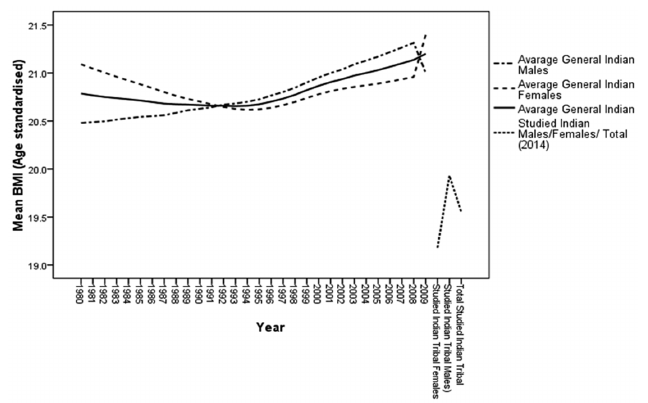
doi:10.1371/journal.pone.0147934.g002